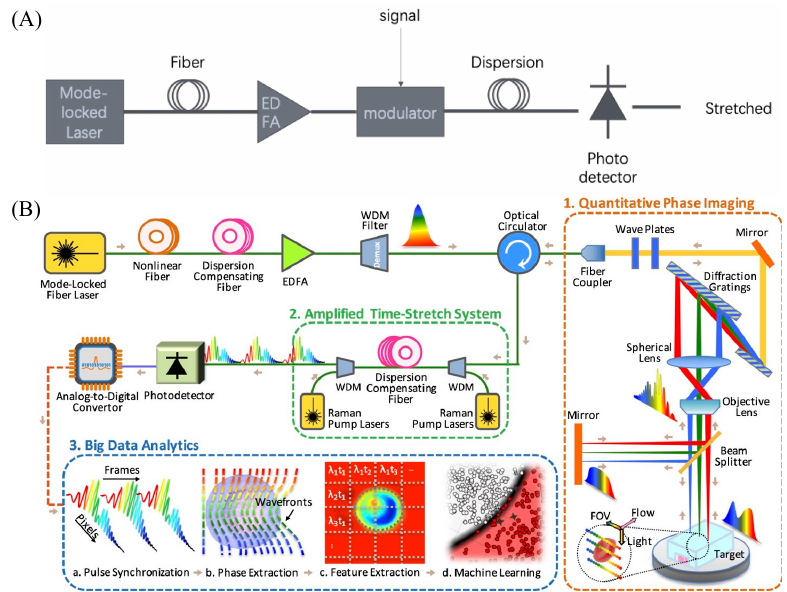
Figure 5. ( A ) PTS schematic diagram of principle. ( B ) OTS-QPI system operational process [104].